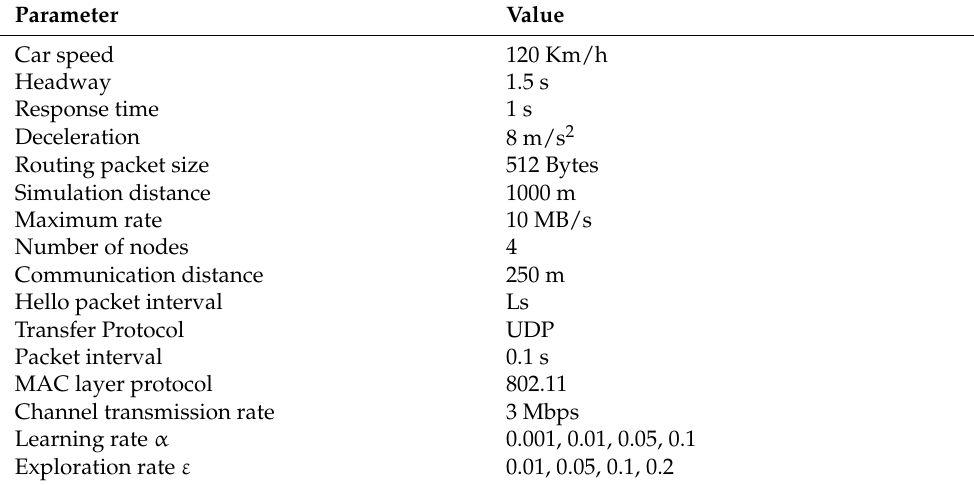
Table 1. Assumed speed and routing protocol.